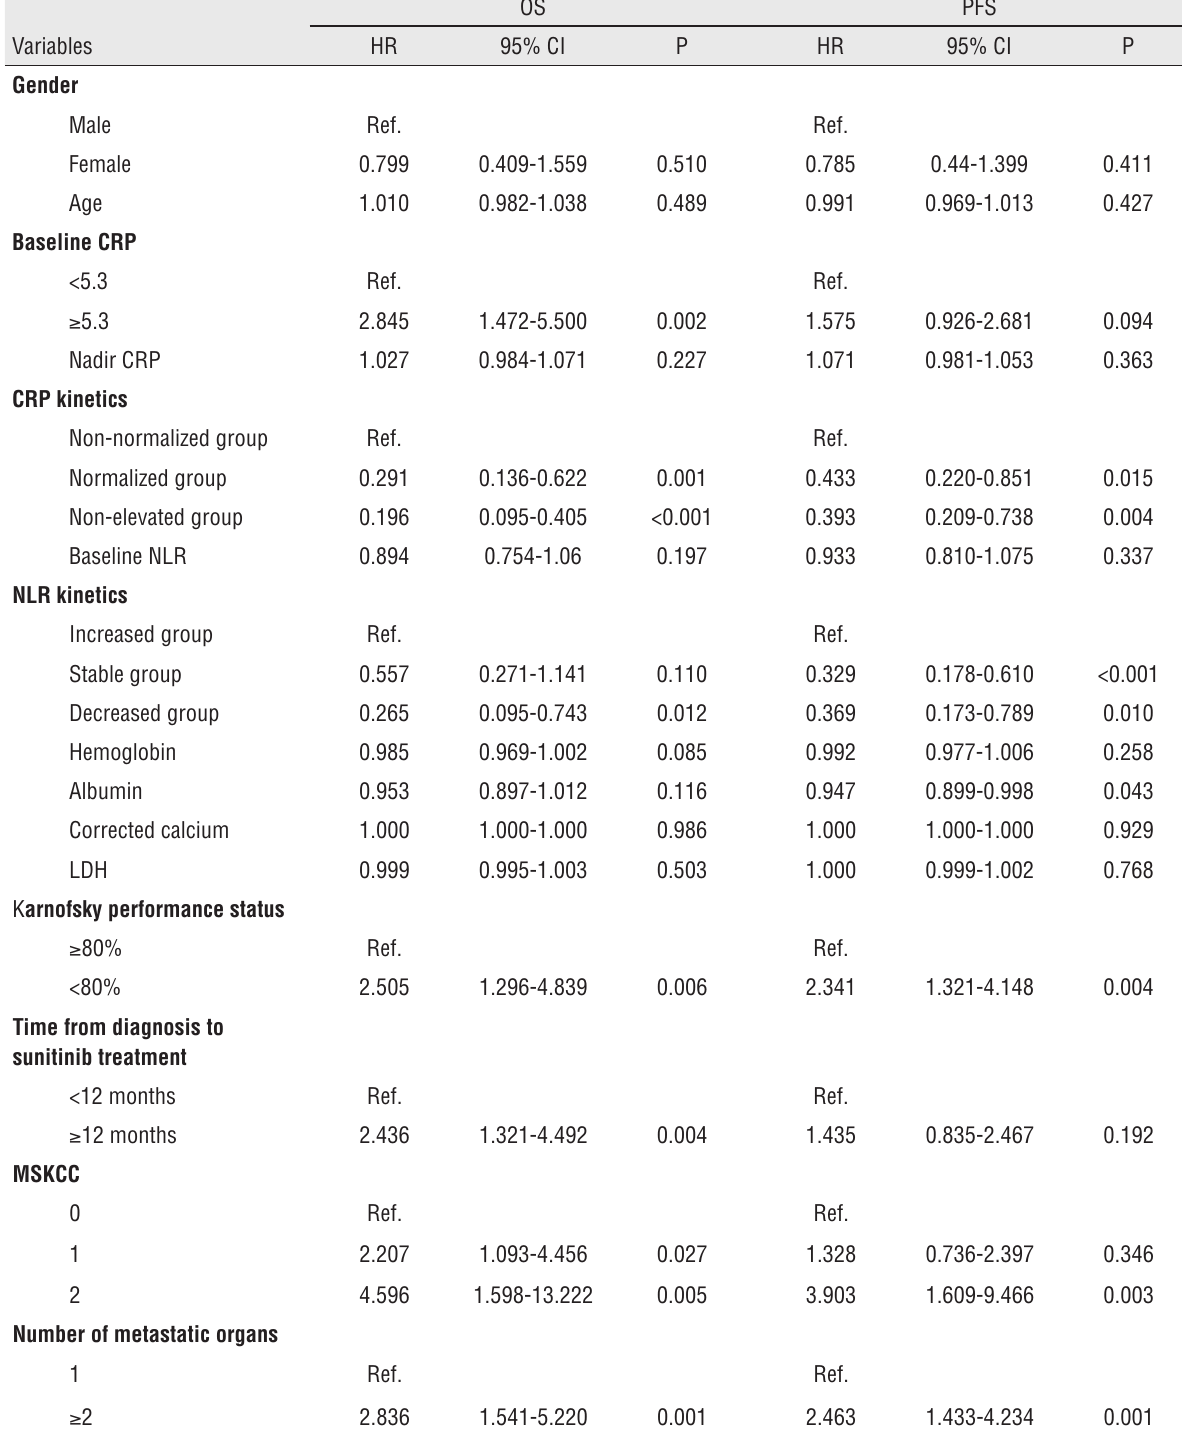
Table 2 - Univariate